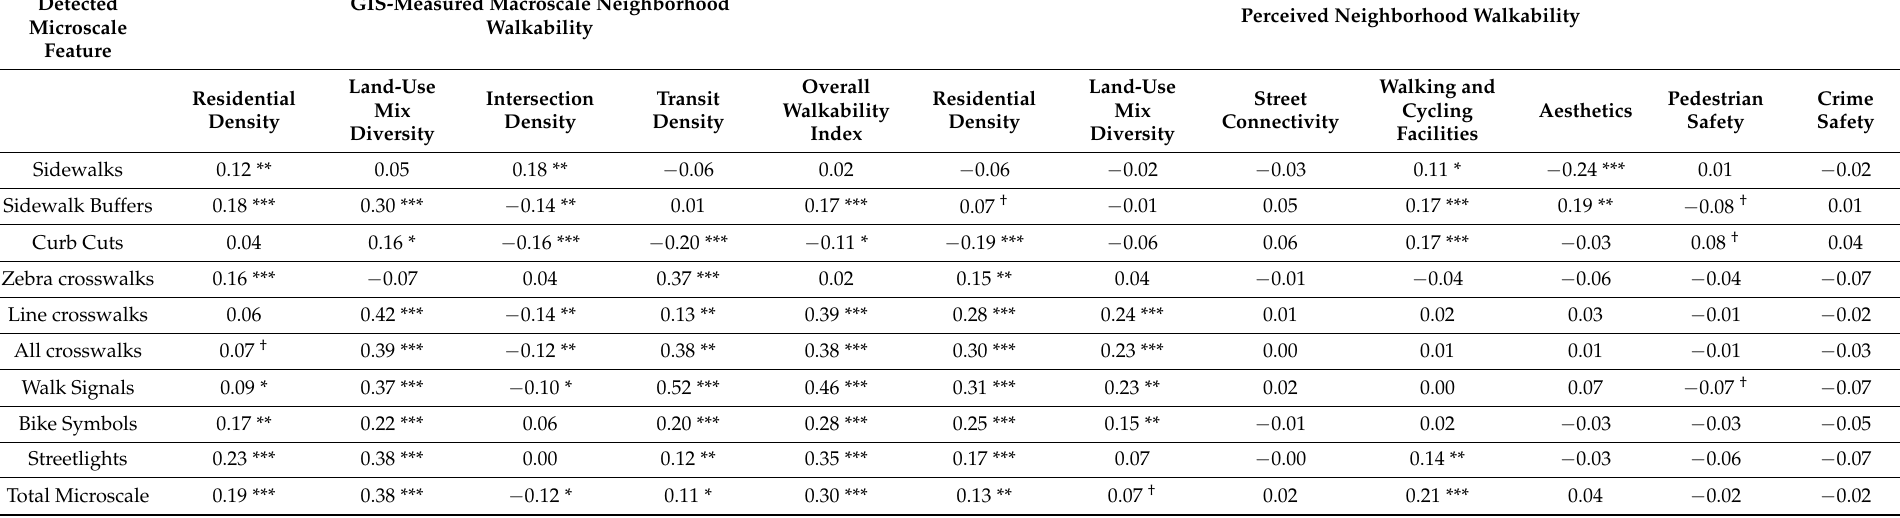
Table 3. Model-detected microscale feature correlations with GIS-measured macro-level walkability and perceived NEWS